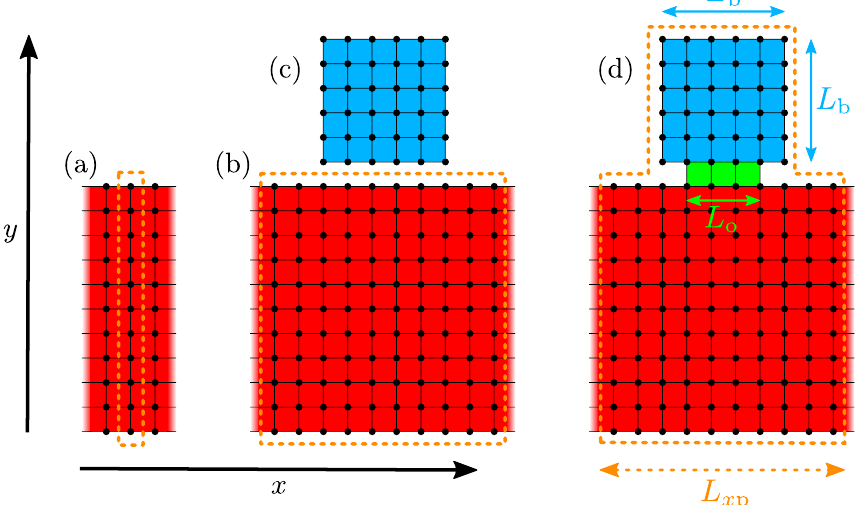
Figure 4: Sketches of the meshes used to capture the physics of the quantum Hall sample with and without bays. The strip geometry (a) and the rectangular geometry (b) are used to describe the sample without bays. The decoupled bay (c) is considered to compute the energy spectrum of the isolated bay as reference for the coupled system shown in panel (d). The orange dashed lines indicate the respective unit